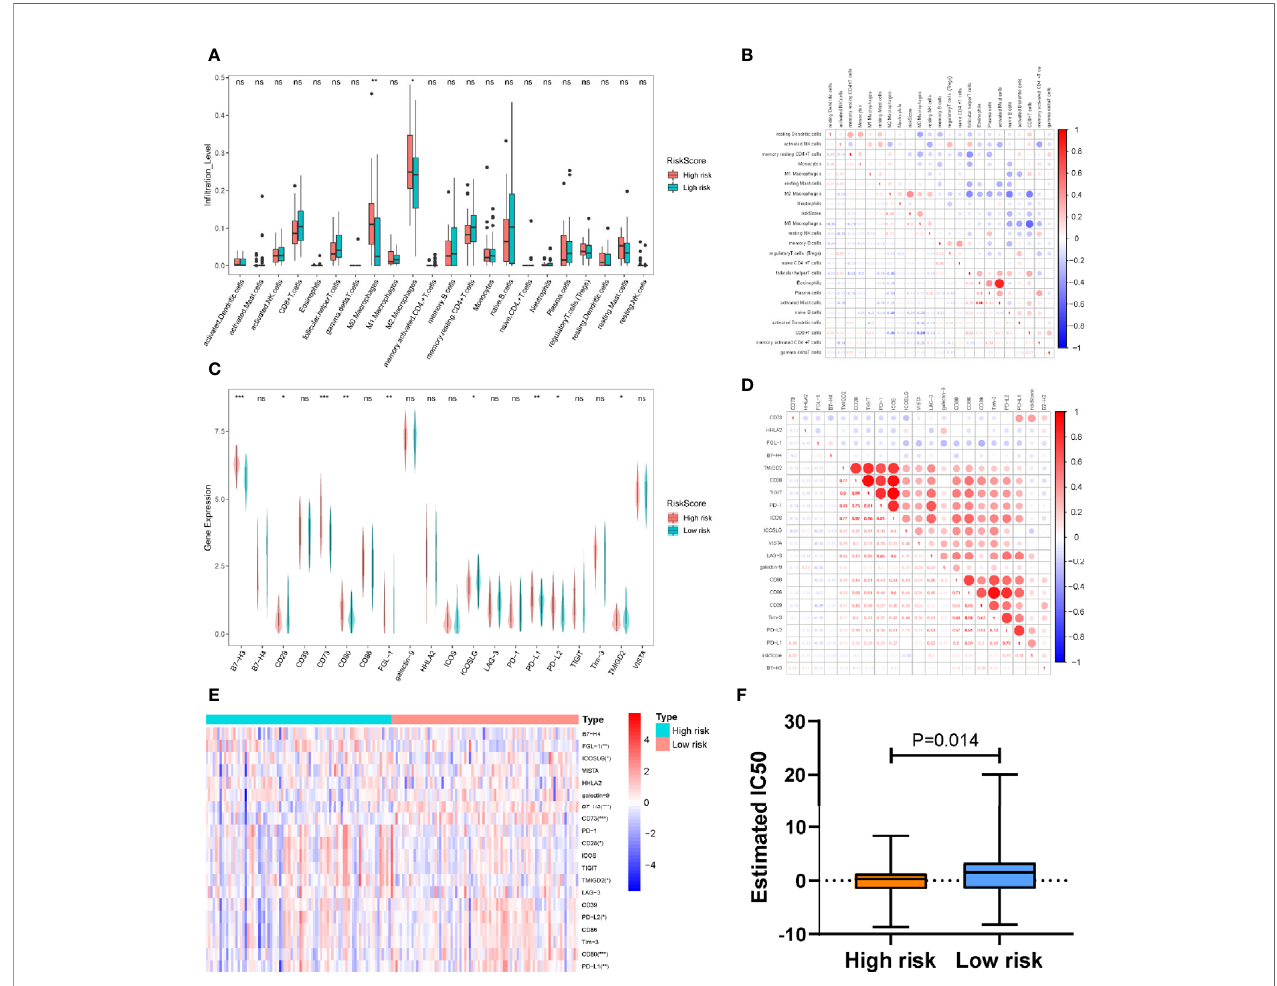
FIGURE 6 | (A) Differences in the in fi ltration abundance of immune cells between the high-set and low-risk sets. (B) Cross correlogram derived based on Pearson ’ s correlation coef fi cient values between PAISs and 22 tumor-in fi ltrated immune cells. (C) Heatmap of immune checkpoint pro fi les in the high- and low-risk sets. (D) Differences in the expression of immune checkpoint molecules between the high-set and low-risk sets. (E) Cross correlogram derived based on Pearson ’ s correlation coef fi cient values between PAIS and the expression of immune checkpoint molecules. ns no signi fi cant, *P < 0.05, **P < 0.01, ***P < 0.001. (F) Boxplots evaluating the response to the paclitaxel chemotherapeutic between high-and low-risk